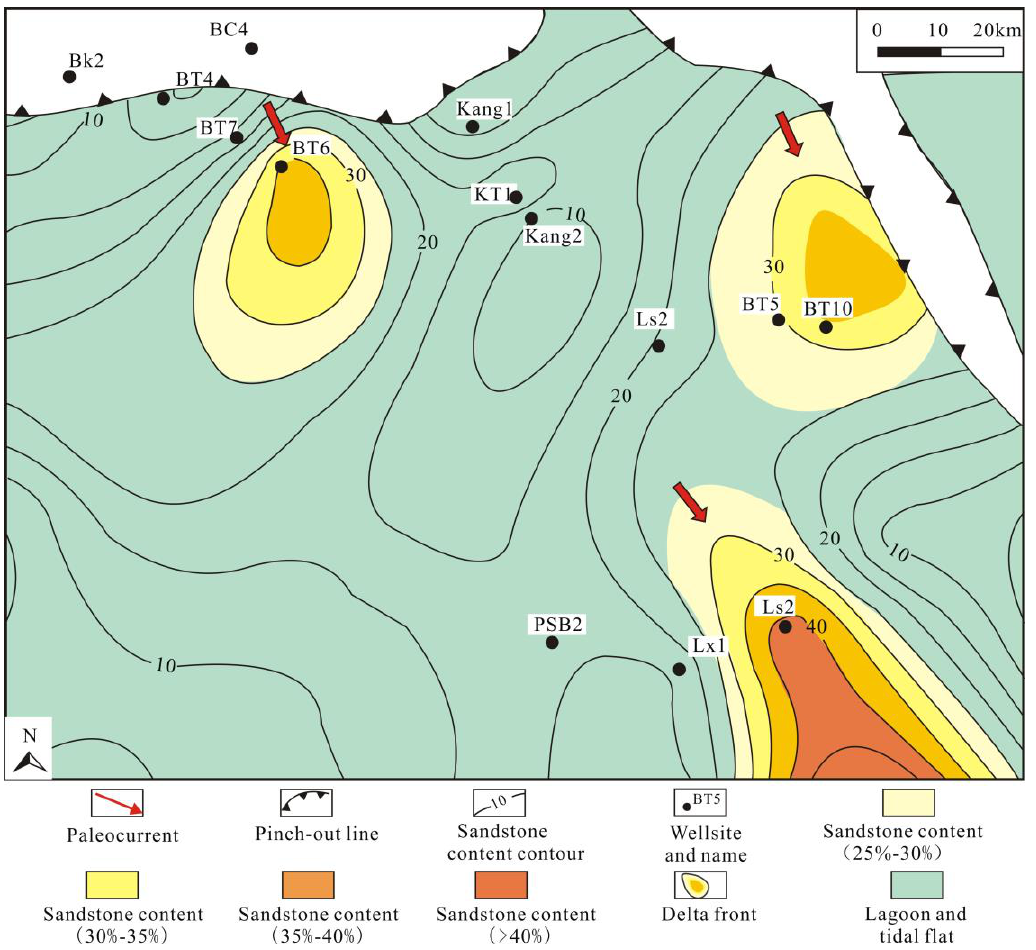
Figure 11. Depositional facies map of the Carboniferous Karashayi Formation in the Bamai area.